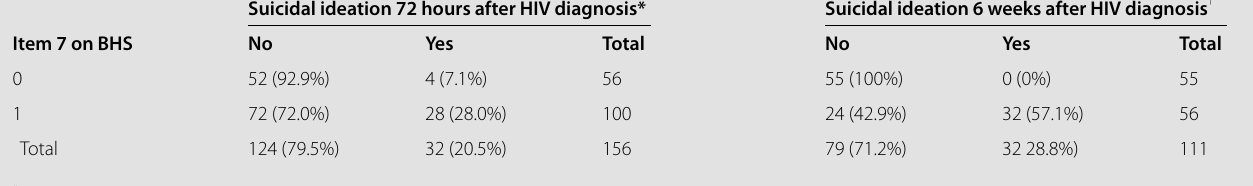
Table 2. The association between suicidal ideation on the BHS scores and item 7 on the BHS 72 hours and 6 weeks after HIV test result Suicidal ideation 72 hours after HIV diagnosis*